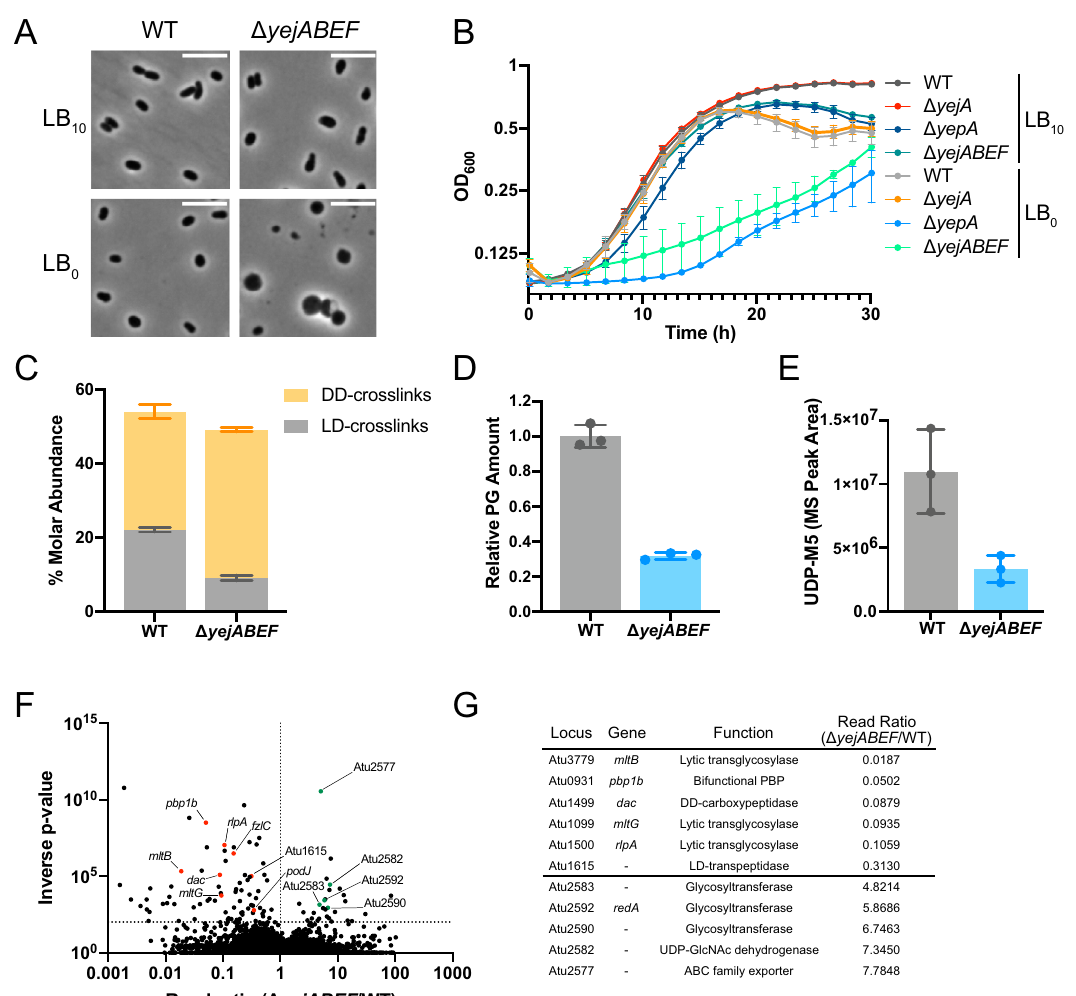
Fig. 4 | PG recycling is required for cell wall integrity in A. tumefaciens . A – E Phenotypic analysis of A. tumefaciens WT and Δ yejABEF strains. A Phase con- trastmicroscopyofWTand Δ yejABEF cellsgrownonLB 10 andLB 0 .Scalebarlength is 5 μ m. Images are representative of three biologically independent replicates. B Growth curves of WT and Δ yejABEF on LB 10 and LB 0 . n =3 biologically indepen- dent experiments, error bars represent standard deviation from mean. C Molar abundance of DD- and LD-crosslinks in cell walls determined by UPLC analysis of WTand Δ yejABEF PG. D Relative PG amountsdeterminedby totalareaunderUPLC chromatogramsofWTand Δ yejABEF PG. E LC-MSquanti fi cationofprimarysoluble